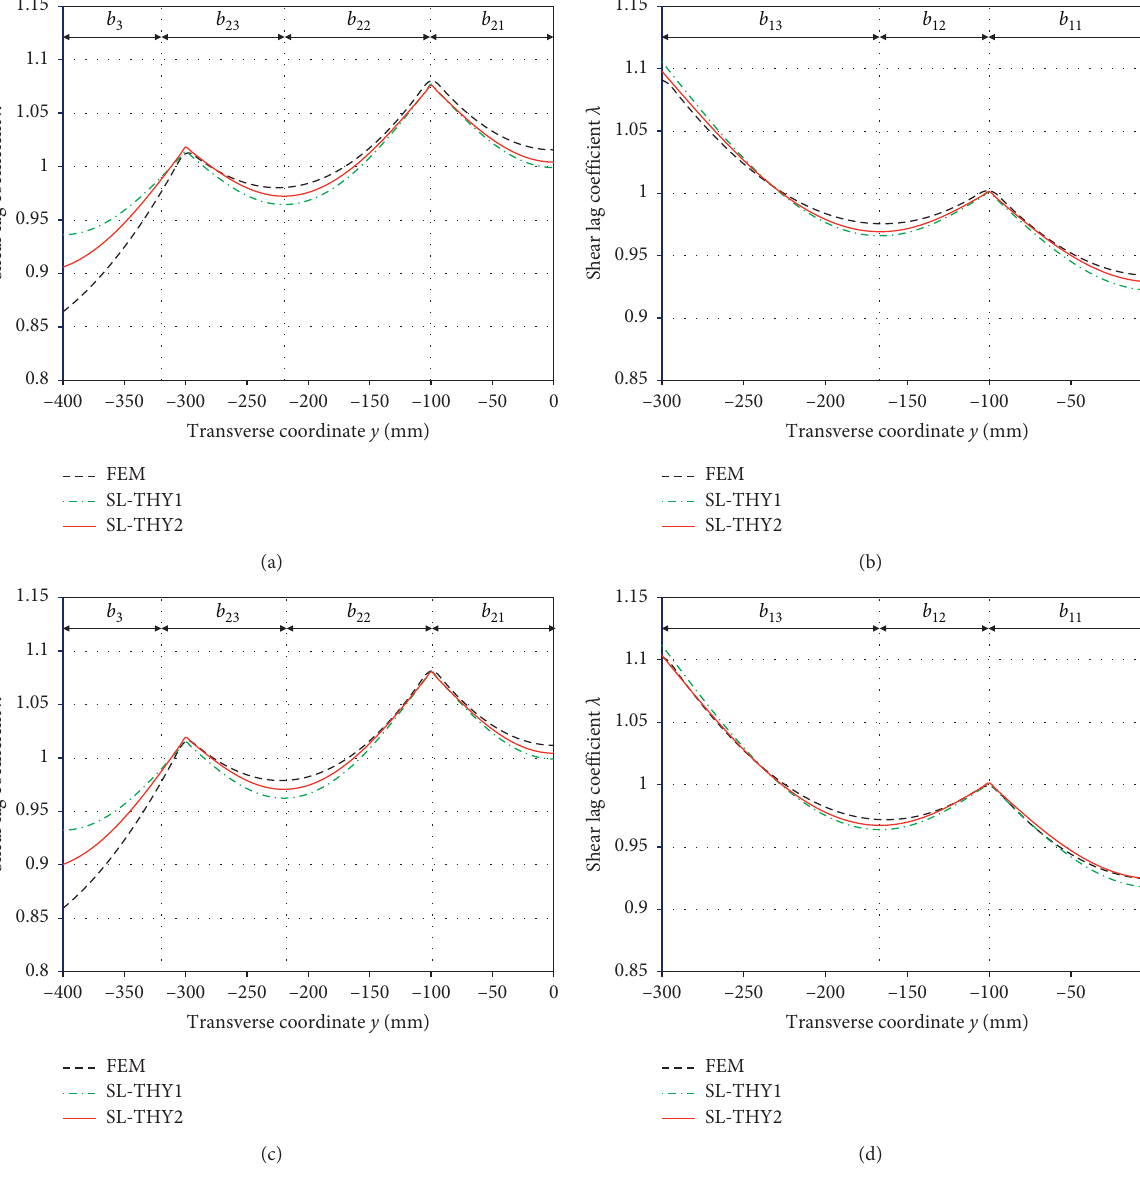
Figure 14: Shear lag coefficients of the simply supported box girder. (a) Top flanges of midspan cross section ( x � 600mm). (b) Bottom flanges of midspan cross section ( x � 600mm). (c) Top flanges of 3/8-span cross section ( x � 450mm). (d) Bottom flanges of 3/8-span cross section ( x �